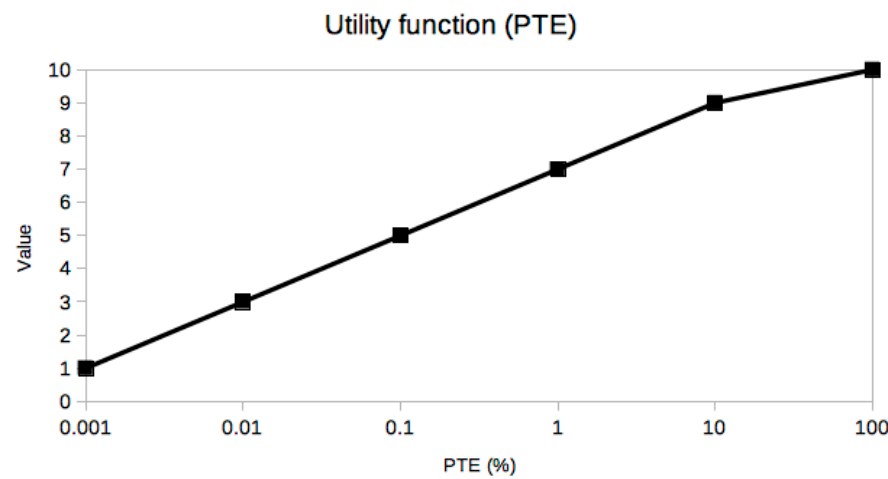
Figure 5. Utility function for Power Transmission Effectiveness.